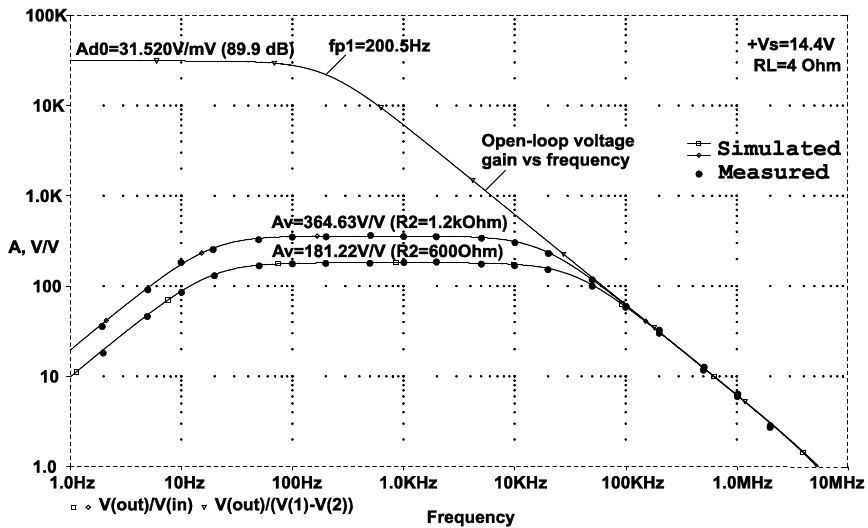
Figure 6. Test circuit [17] for simulation and experimental testing at various voltage gains A V , through the feedback resistor R 2 .